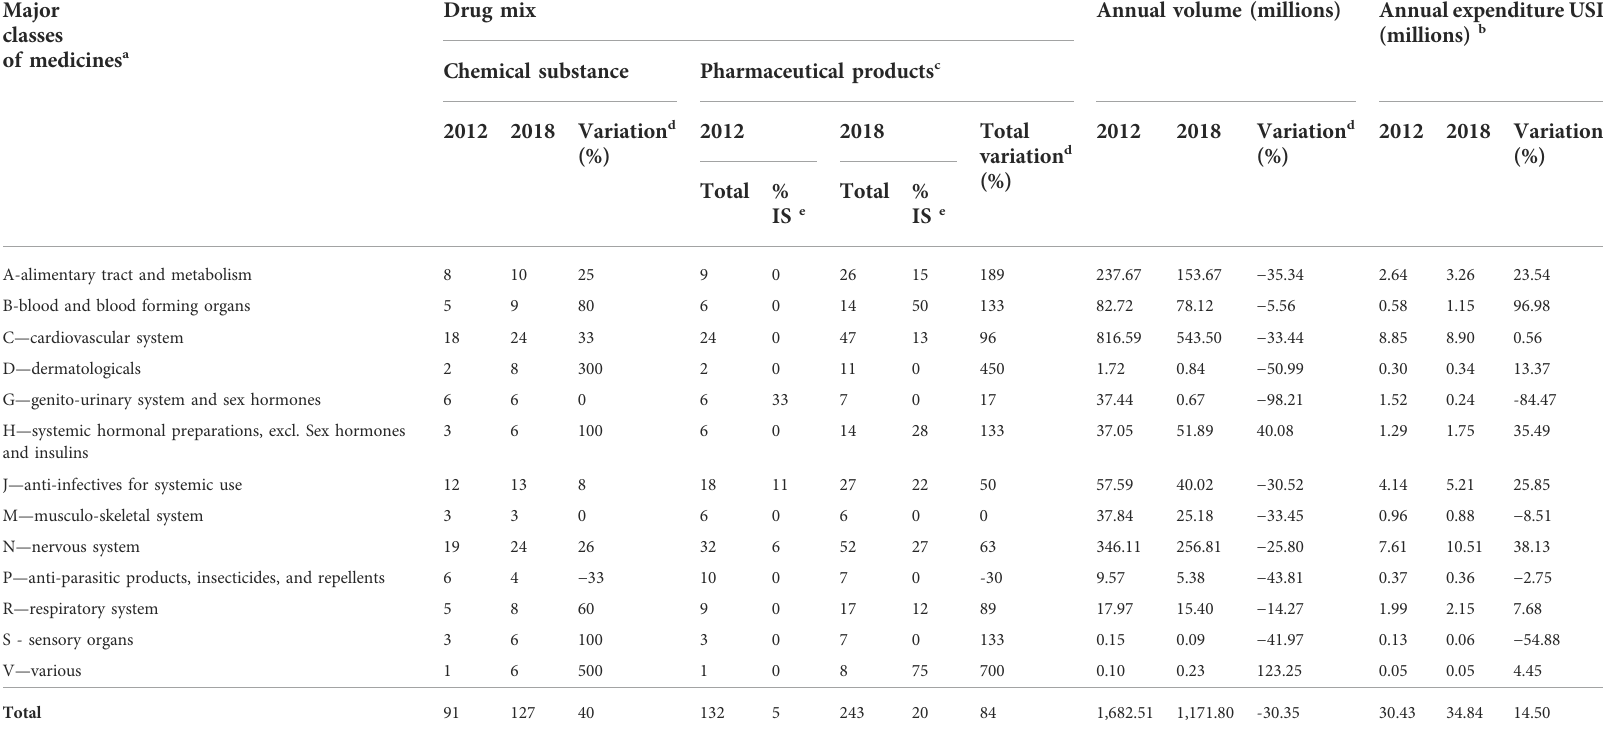
TABLE 1 Major classes of medicines, drug mix, annual volume, and expenditure in 2012 and in 2018 and variations in the period. Minas Gerais,